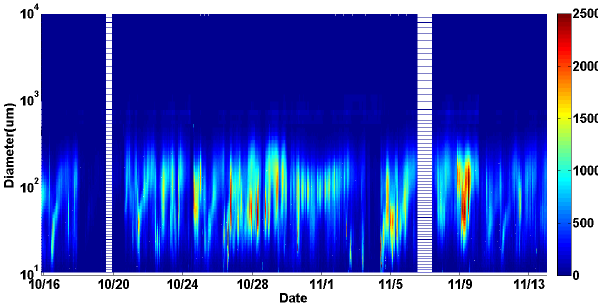
Figure 3. Time series of the number size distribution (dry particles) during the observation